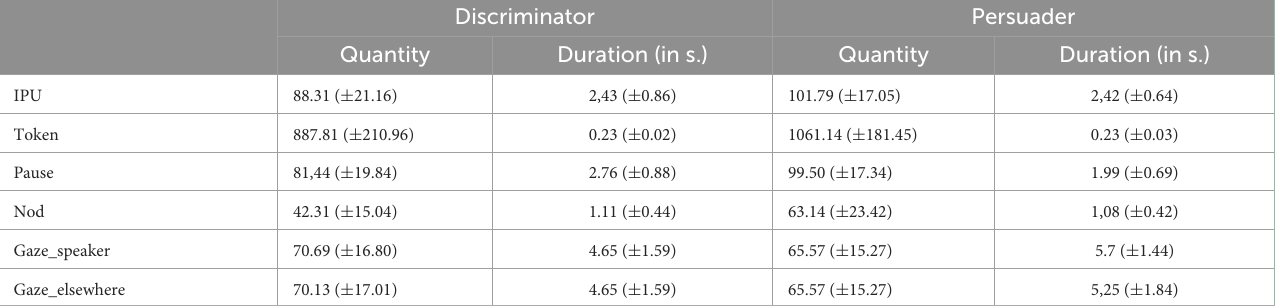
TABLE 3 Descriptive statistics of the annotations according to the role of the actors.